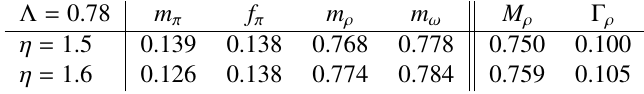
Table 1. The pion mass m π , the pion decay constant f π , the ρ -meson and ω -meson masses m ρ and m ω for the two di ff erent used parameterisations of the model (labeled with η ) and for the case with gluon- and pion-exchange kernels but without decay kernels are shown. The current quark mass has been set to m q = 6 . 8 MeV. The two rightmost, separated, columns display for the case when including the dimensionful quantities are given in GeV.